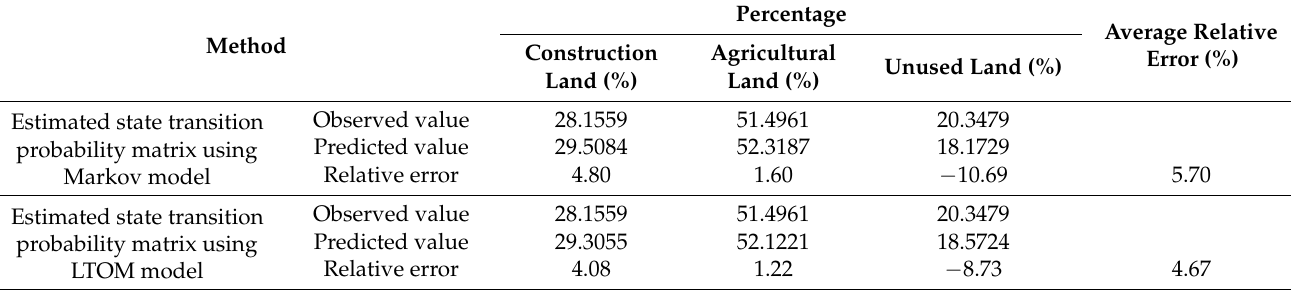
Table 3. Prediction results and accuracy of the area percentage of three types of land use in Nansha District in 2020 with 2015 as the base period (5-year